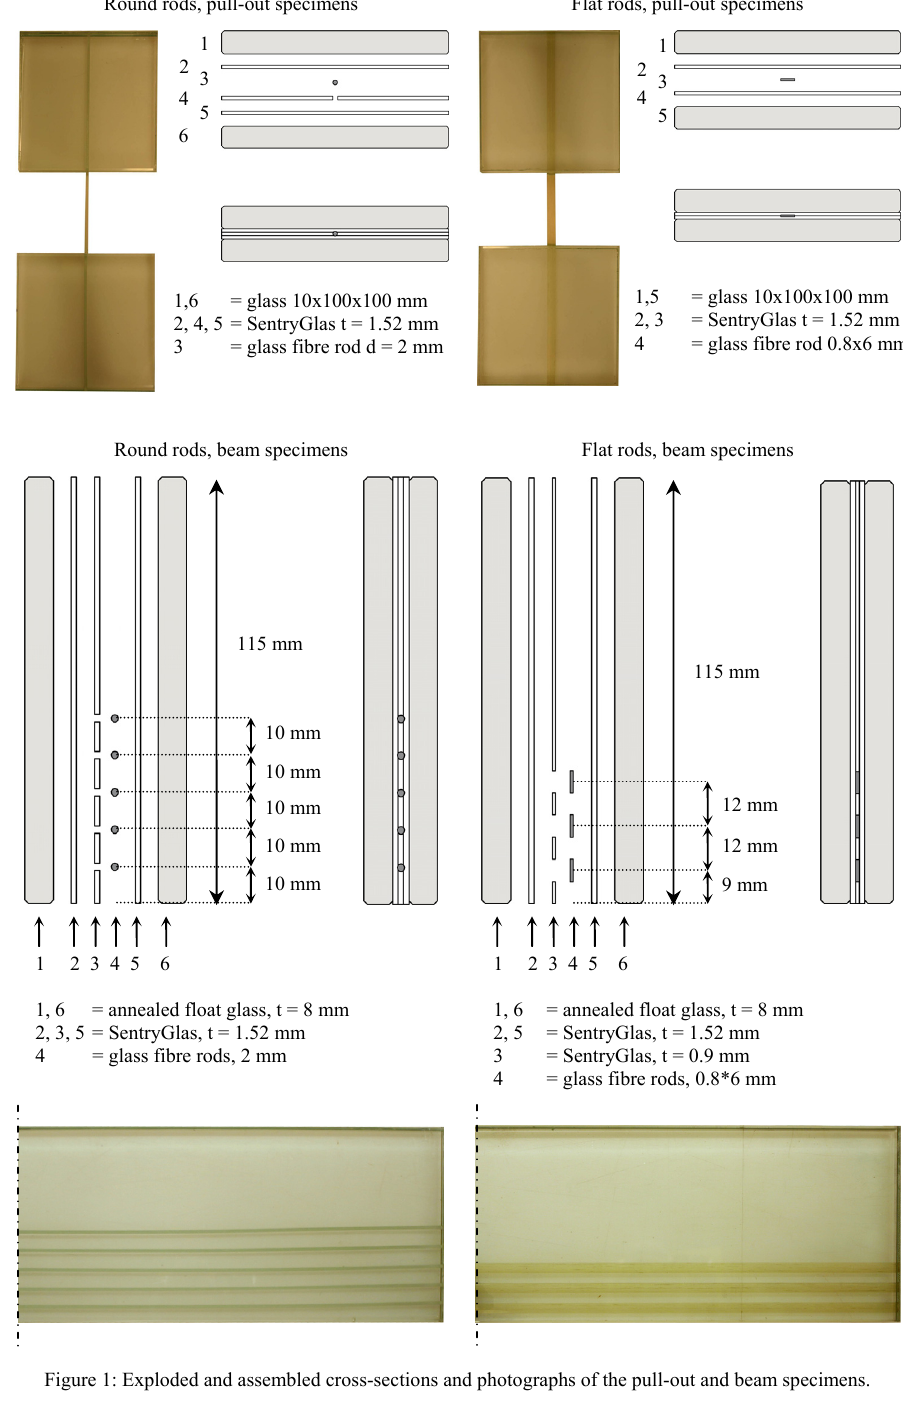
Figure 1: Exploded and assembled cross-sections and photographs of the pull-out and beam